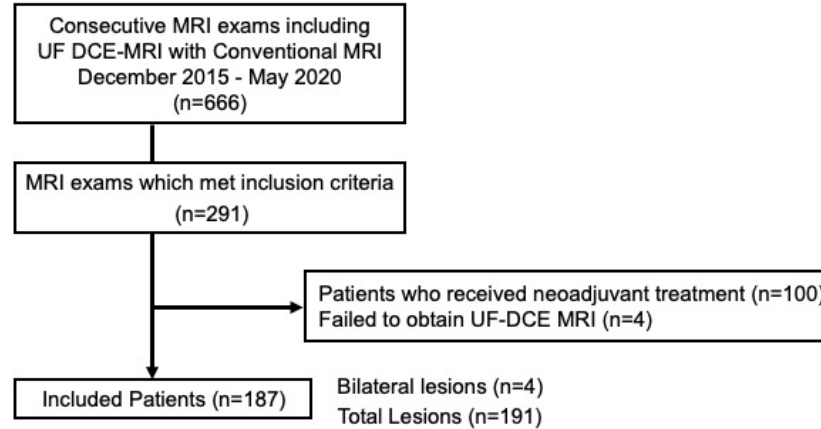
Figure 1. Flow diagram of the study population. UF DCE Ultrafast dynamic contrast-enhanced.